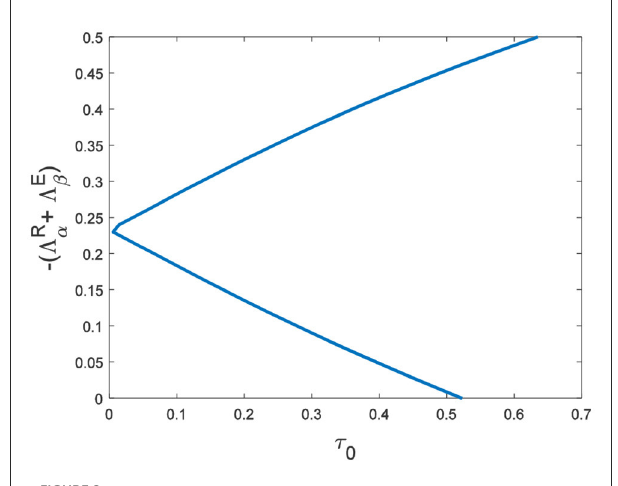
FIGURE7 D u D v 0. (A) Bifurcation diagram about τ . The bifurcation point is τ = =